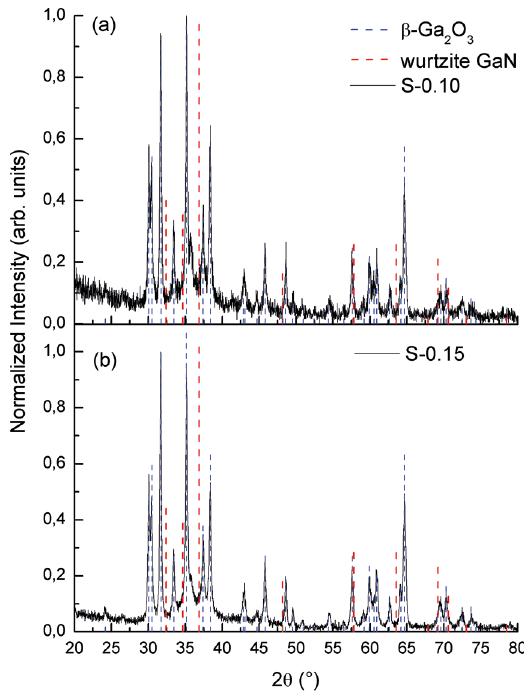
Figure 2. XRD diffraction patterns of samples: (a) S-0.10 and (b) S-0.15. The patterns of both samples are quite similar; however, sample S-0.15 has improved its crystallinity as compare to S-0.10. In sample S-0.15, the background intensity as well as the noise signal